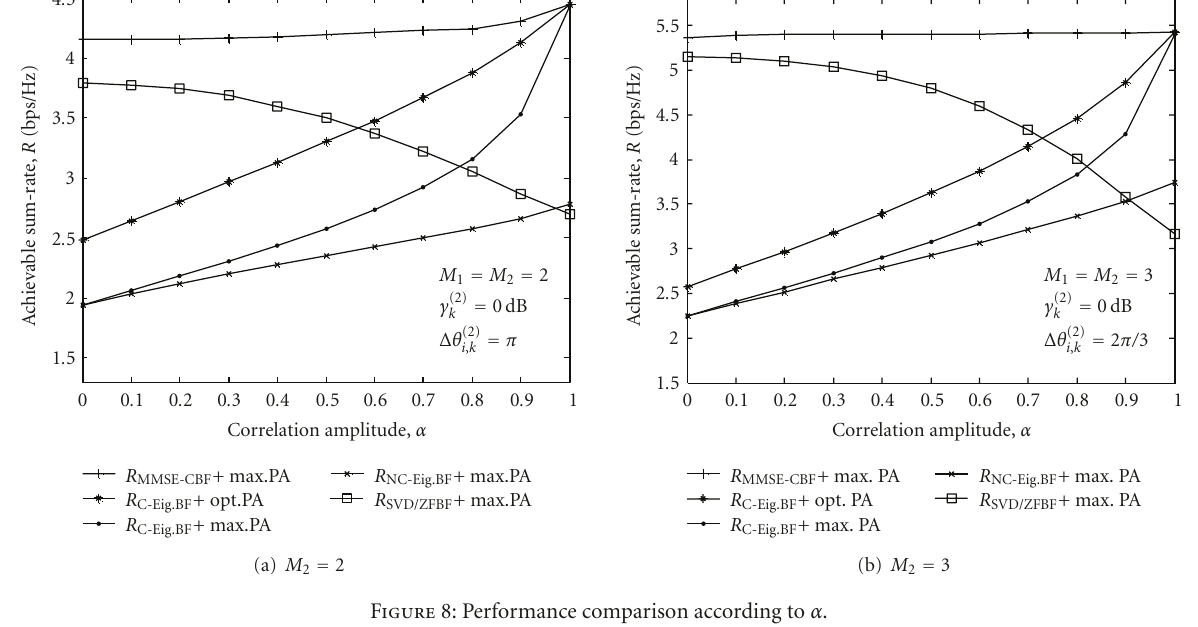
Figure 8: Performance comparison according to α .